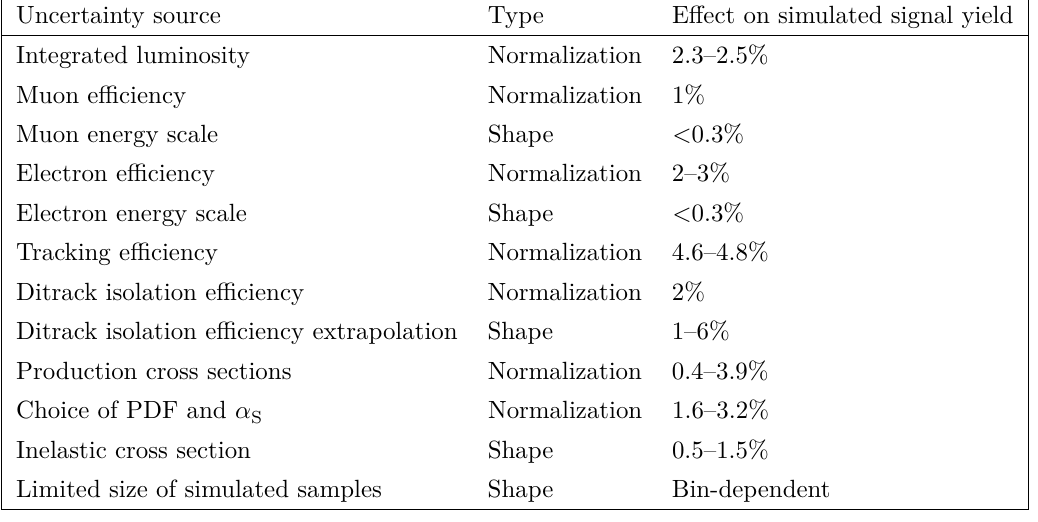
Table 2 . Effect of systematic uncertainties on the simulated signal. The ranges reflect differences between channels and data-taking